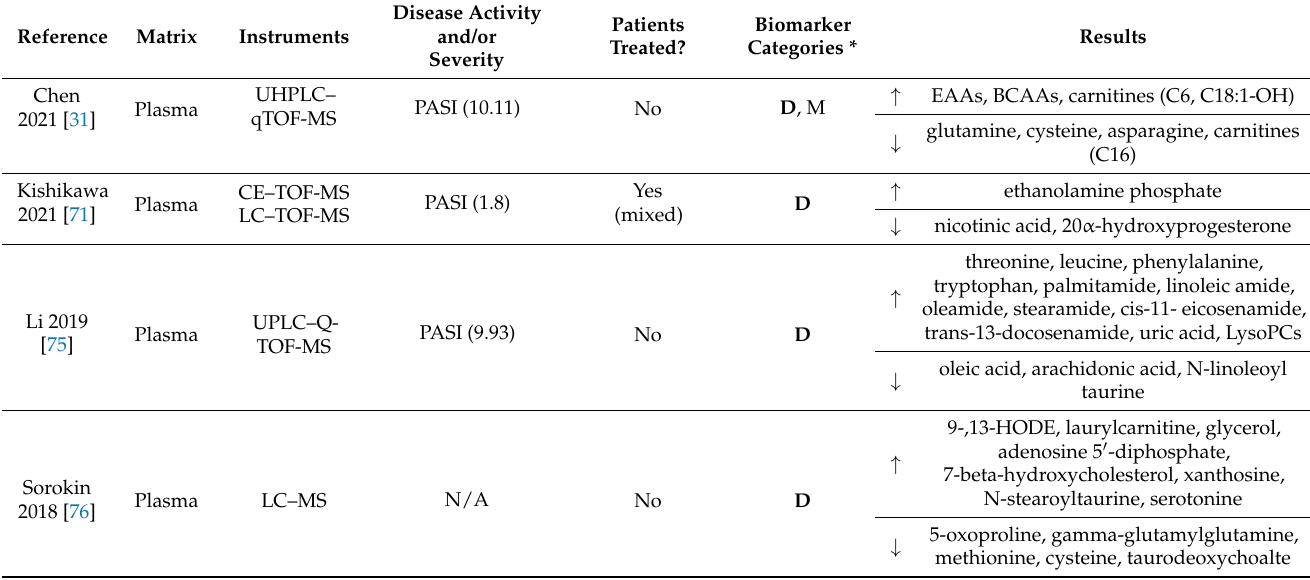
Table 3. Changed metabolites in psoriasis (Ps). Biomarker category highlighted in bold: Correspond- ing metabolites listed in column